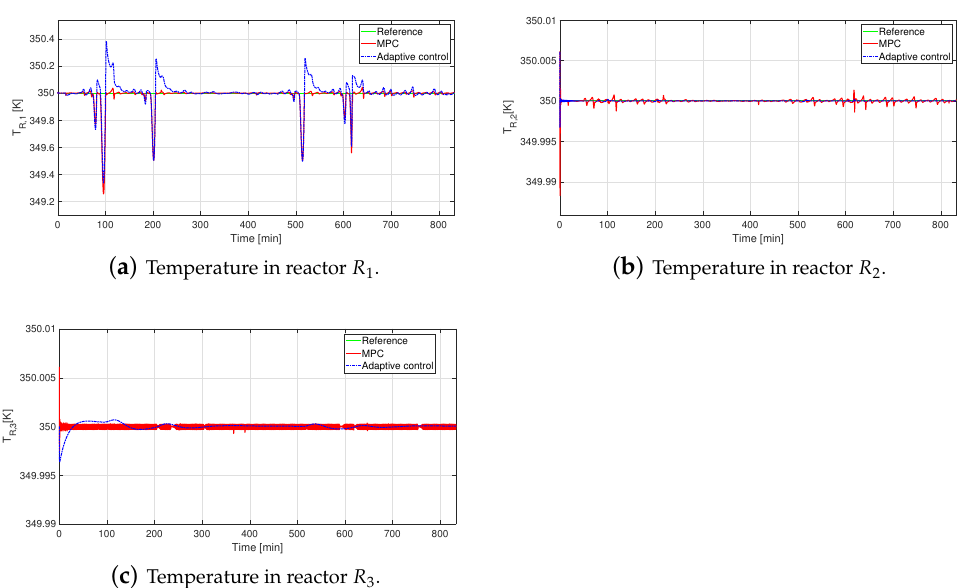
Figure 14. Performance of adaptive controller under a simultaneous disturbance -Temperature output in each reactor, T R , i .